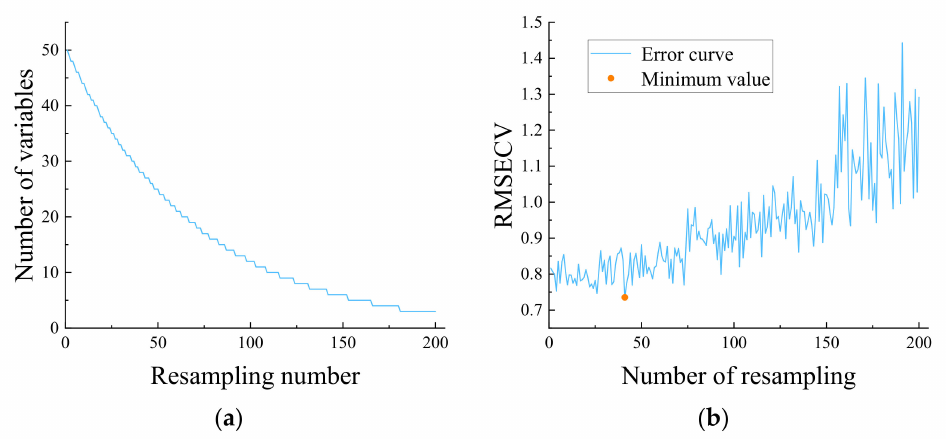
Figure 13. MCUVE–CARS screening process. ( a ) Variable selection process. ( b ) RMSECV